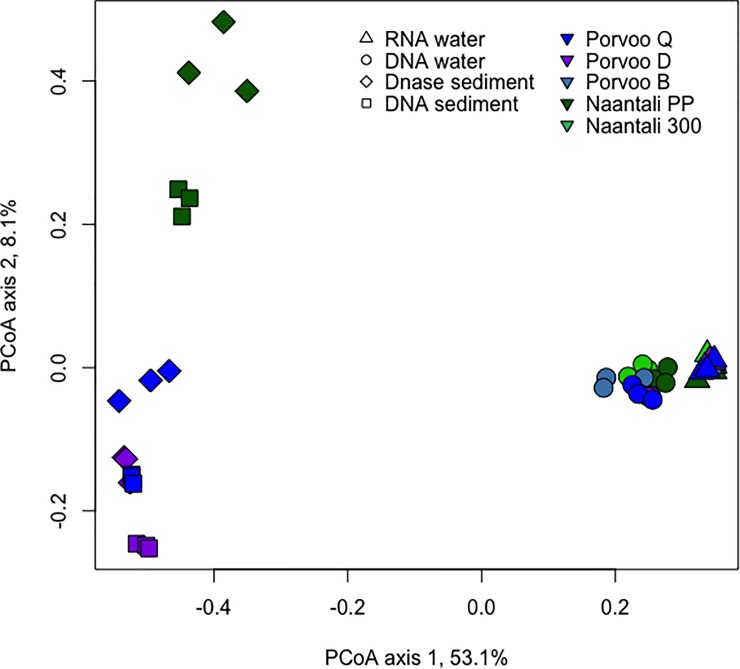
Principal coordinates analysis of archaeal sequences from water and sediment samples.No sequence data was obtained from Naantali 300 and Porvoo B sediment samples.